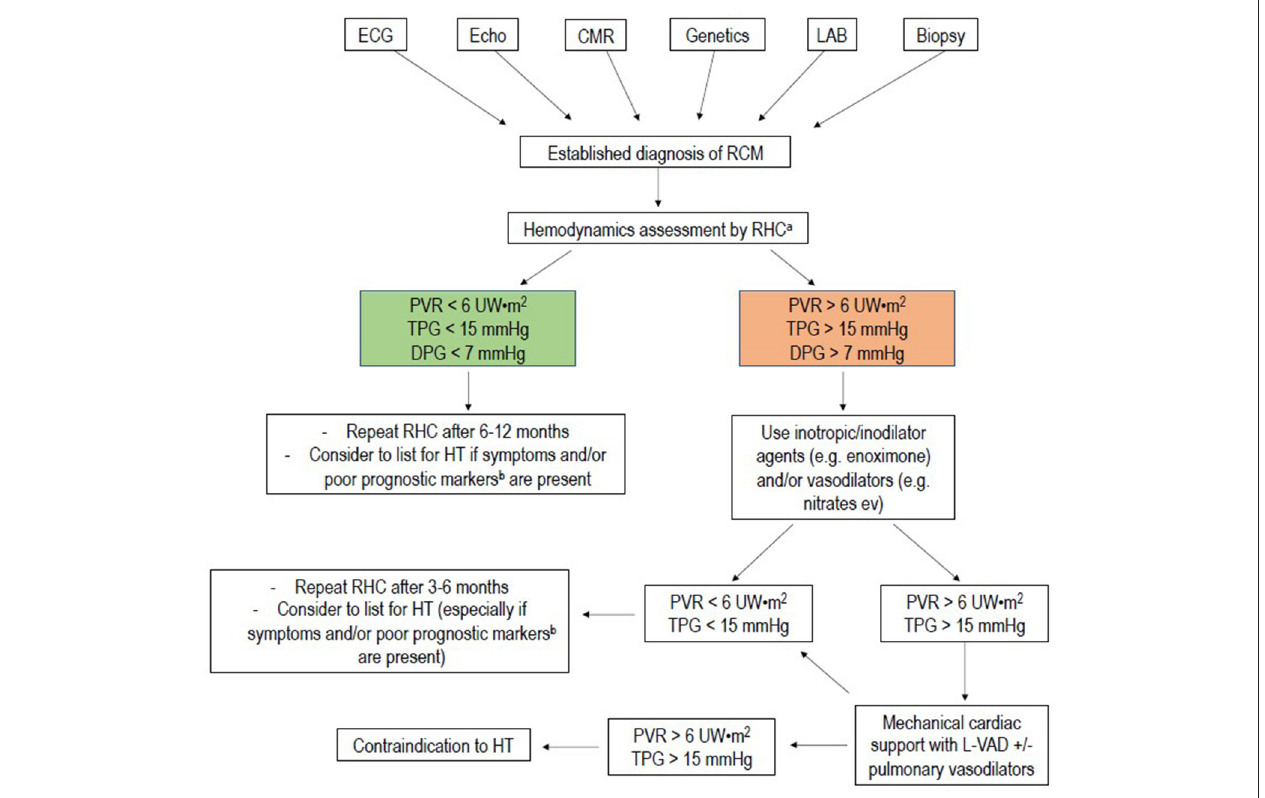
FIGURE 6 | Flow-chart of management of pediatric restrictive cardiomyopathy. RHC, right heart catheterization; PVR, pulmonary vascular resistance; mPAP, mean pulmonary artery pressure; TPG, transpulmonary gradient; DPG, diastolic pulmonary gradient; HT, heart transplantation. a RHC is usually indicated for all patients referred for heart transplantation. RHC in addition, may help to stratify prognosis in patients in NYHA class I to II: severe pulmonary hypertension and low cardiac output can develop even in absence of symptoms, leading to late referral for heart transplantation. When at least one of the prognostic indicators for RCM is present, it may be advisable to refer the patient to a tertiary center for HT evaluation. b Poor prognostic markers are: pulmonary congestion, myocardial ischemia, severe left atrial dilation, male gender, reduction of left ventricular fractional shortening, increased left ventricular walls